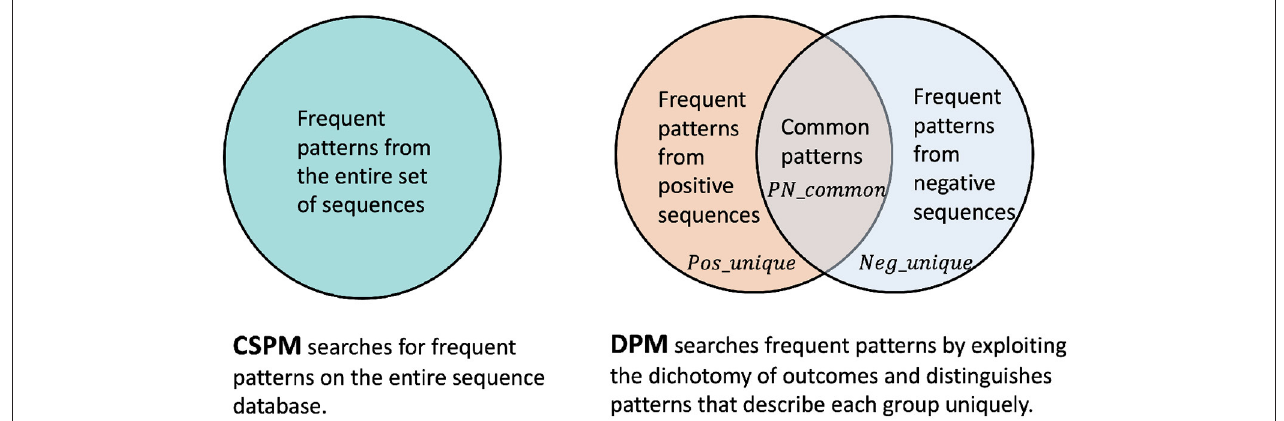
FIGURE 1 | Traditional CSPM that operates on the entire sequence database vs. our DPM approach that exploits the dichotomy of outcomes to distinguish unique positive and negative patterns.